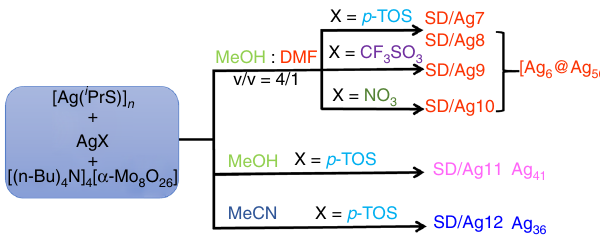
Fig. 1 Schematic representation of the synthesis of clusters SD/Ag7 - SD/ Ag/12 . These clusters are formed by a solvent-controlled method